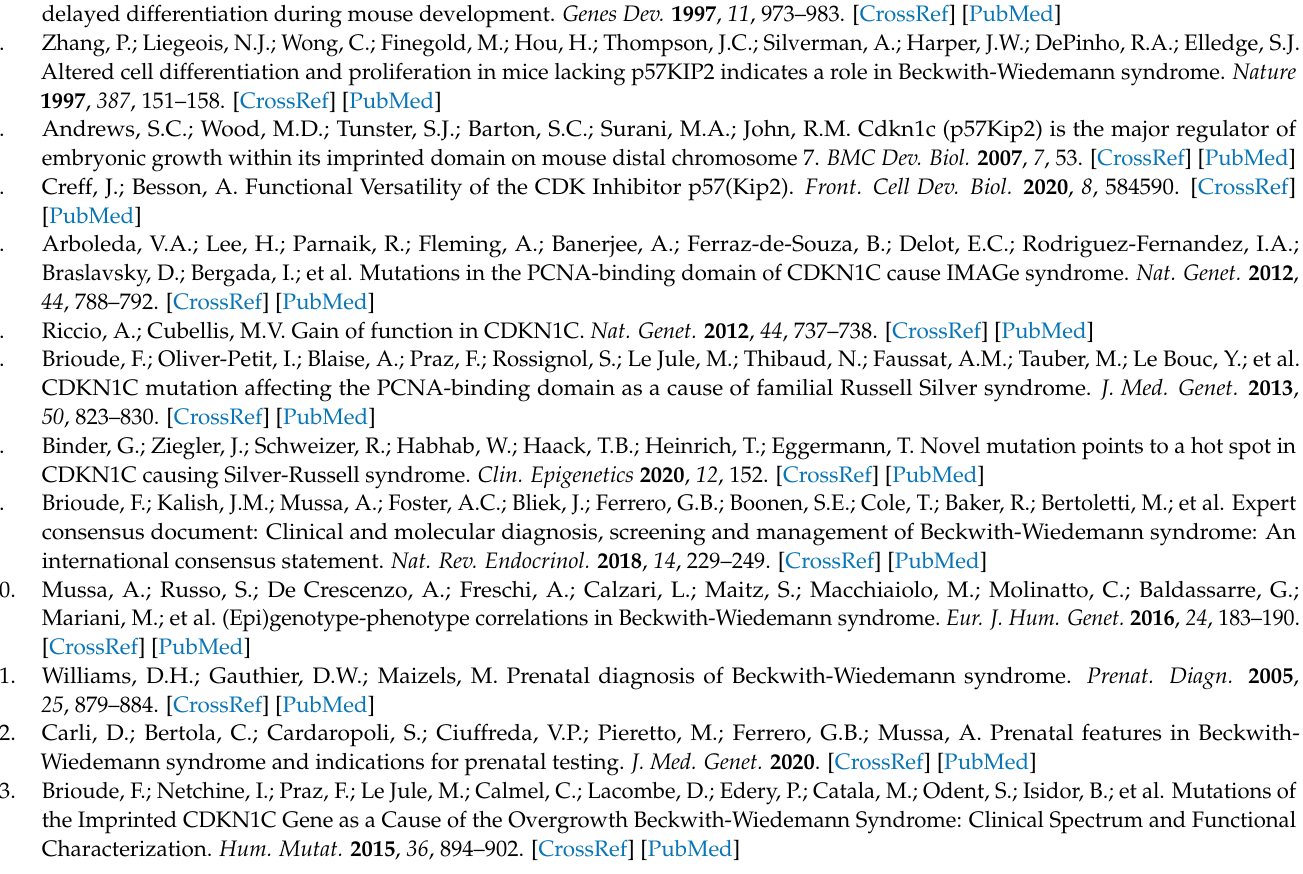
Table S2: Primer pairs and PCR conditions used for CDKN1C amplification. Figure S1: Coding sequence of the CDKN1C